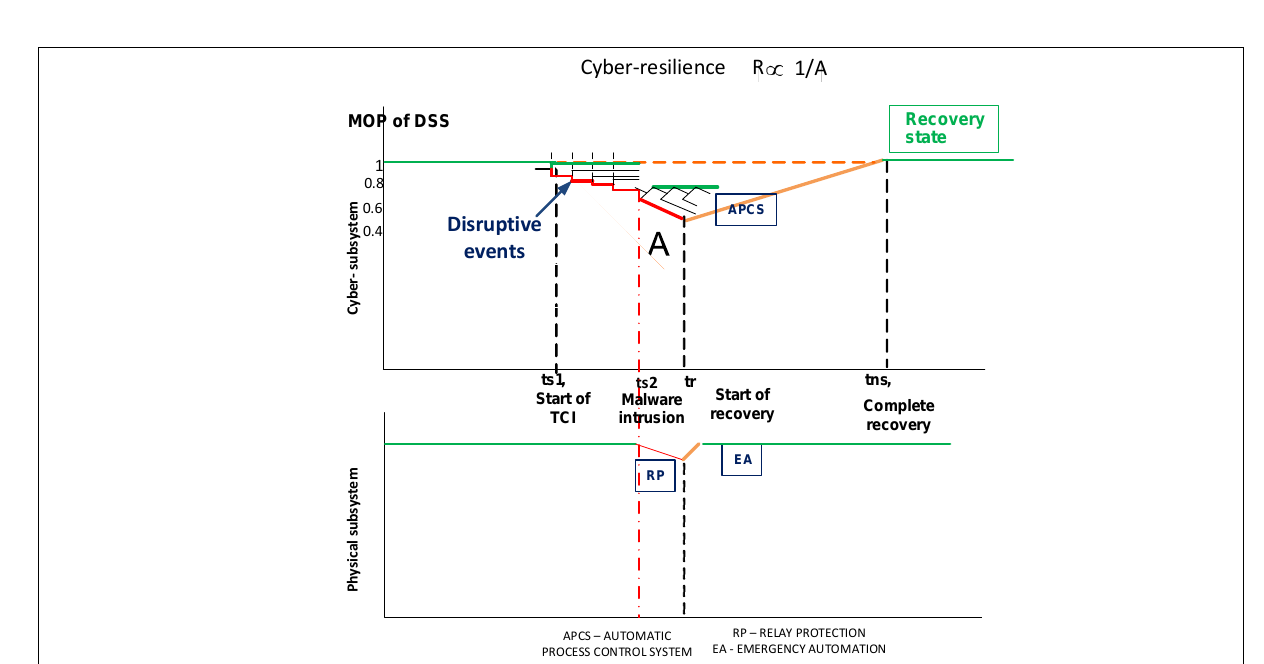
Fig. 7. Interdependence of destabilizing processes in the cyber and physical